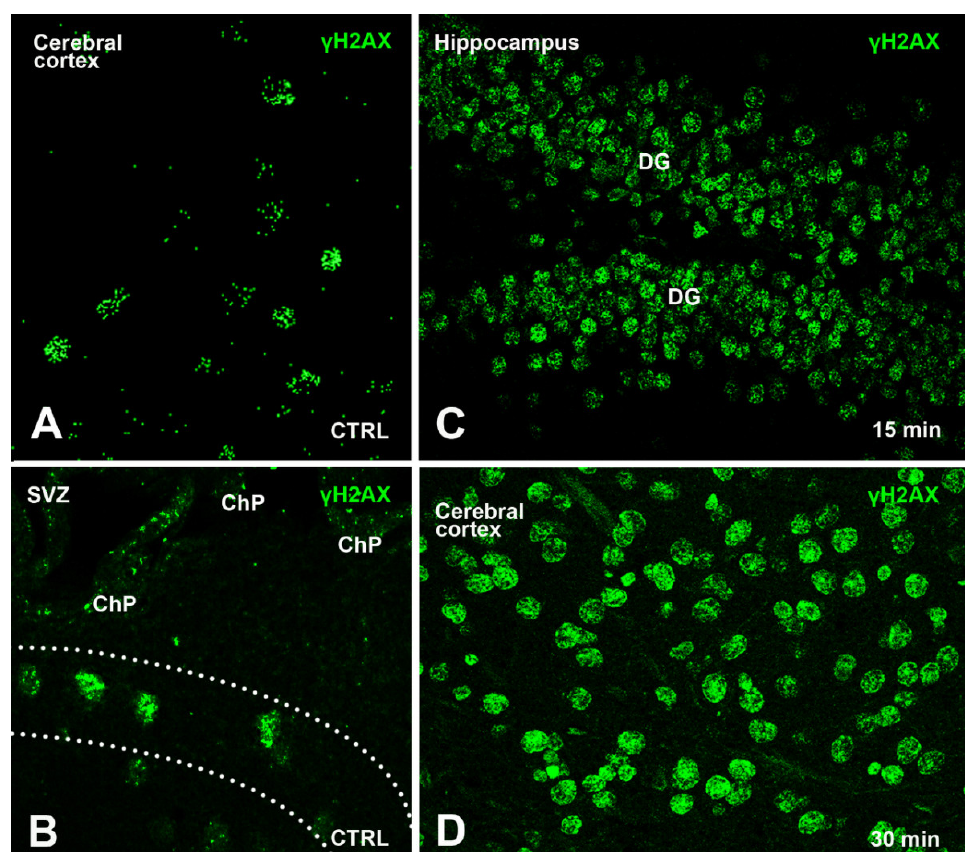
Figure 2. Exemplificative confocal images of γH2AX immunoreactive cells in control and irradiated mice after immunostaining with the Upstate anti-γH2AX antibody. ( A ) Nuclear distribution of γH2AX immunoreactivity in the cerebral cortex of a control mouse. ( B ) γH2AX immunoreactive cells in the SVZ of a control mouse. The dashed lines mark the limits of the SVZ. ( C ) γH2AX immunoreactive cells in the hippocampal dentate gyrus after 15 min irradiation. ( D ) Increase in the number of γH2AX immunoreactive nuclei in the cerebral cortex after 30 min irradiation. Compare with panel A and note the appearance of numerous foci of immunoreactivity. Abbreviations: CTRL = control; ChP = Choroid plexus of lateral ventricle; DG = dentate gyrus of hippocampus. Original magnifications 40×.